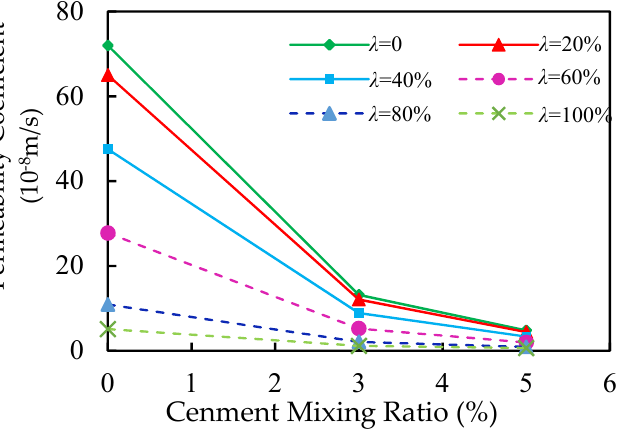
Figure 5. Variations of permeability coefficient with cement mixing ratio.